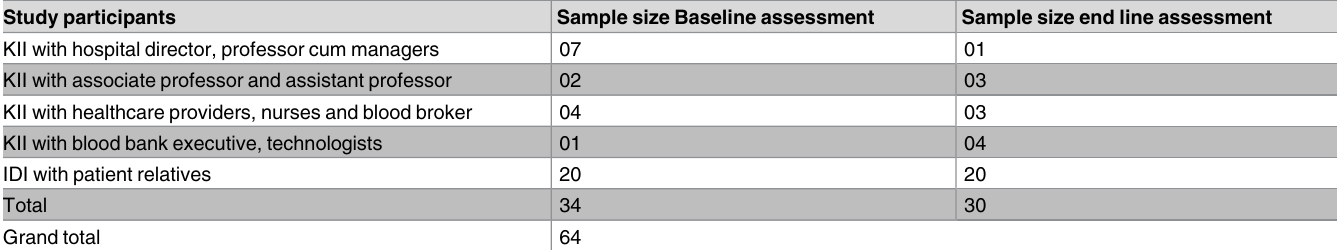
Table 1. Summaryof sample